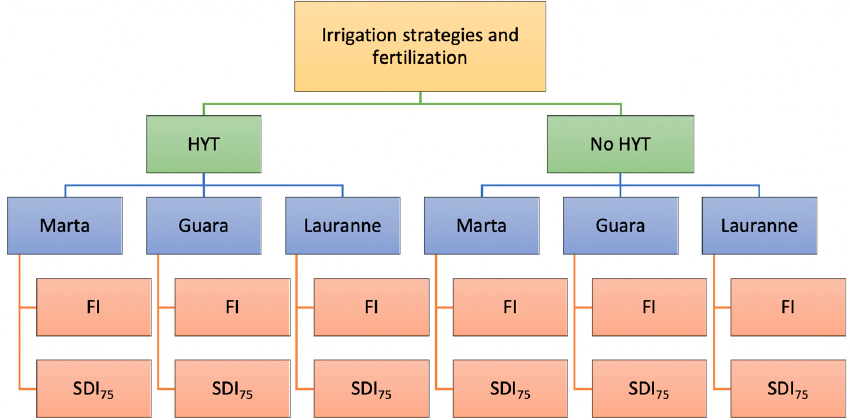
Figure 2. Description of the irrigation treatment and fertilization applied. FI, full irrigation at 100% ET C ; SDI 75 , sustained-deficit irrigation at 75% ET C.